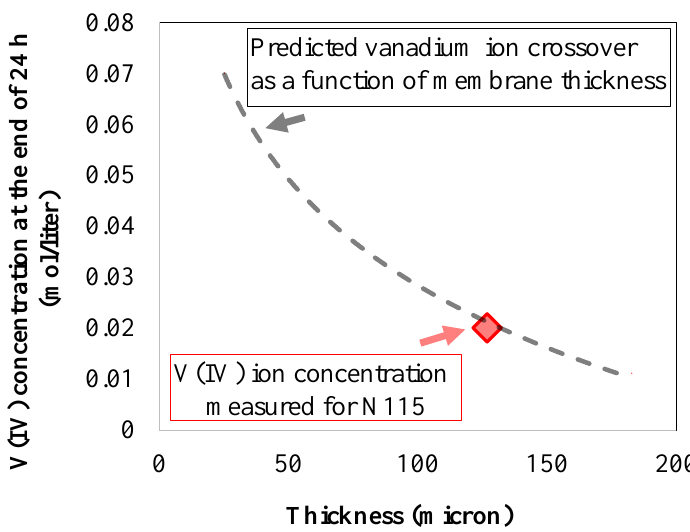
Figure 7. Concentration of the vanadium in the vanadium-deficient electrolyte at the end of the experiment for a cell with single-layer N115 membrane along with predicted vanadium crossover based on Fickian diffusion behavior.